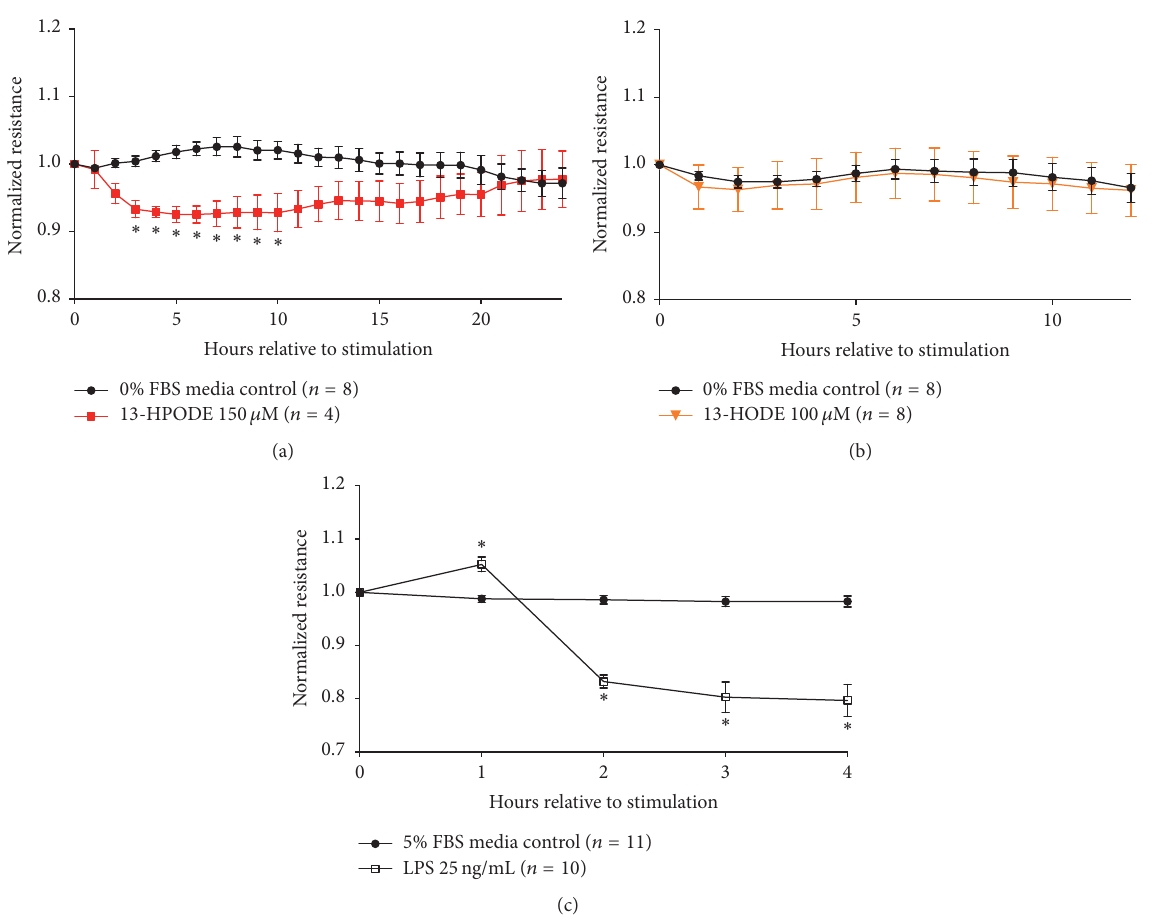
Figure 5: Mean normalized endothelial resistance across time during media control ( ) and 150 𝜇 M 13-HPODE ( ) exposure is displayed in (a). Mean normalized resistance for 100 𝜇 M 13-HODE ( ) exposure up to 6hr is displayed in (b). Mean normalized resistance across time during media control ( ) and 25 ng/mL LPS ( ) is displayed in (c). Resistance of BMEC monolayer across time for each treatment group (control and 13-HPODE, or control and 13-HODE, or control and LPS) was normalized relative to time 0. Significance of differences in resistance across time between treatment groups was tested by a two-way repeated measures ANOVA and adjusted by Bonferroni’s multiple comparisons test. An asterisk ( ∗ ) represents significance declared at 𝑃 ≤ 0.05